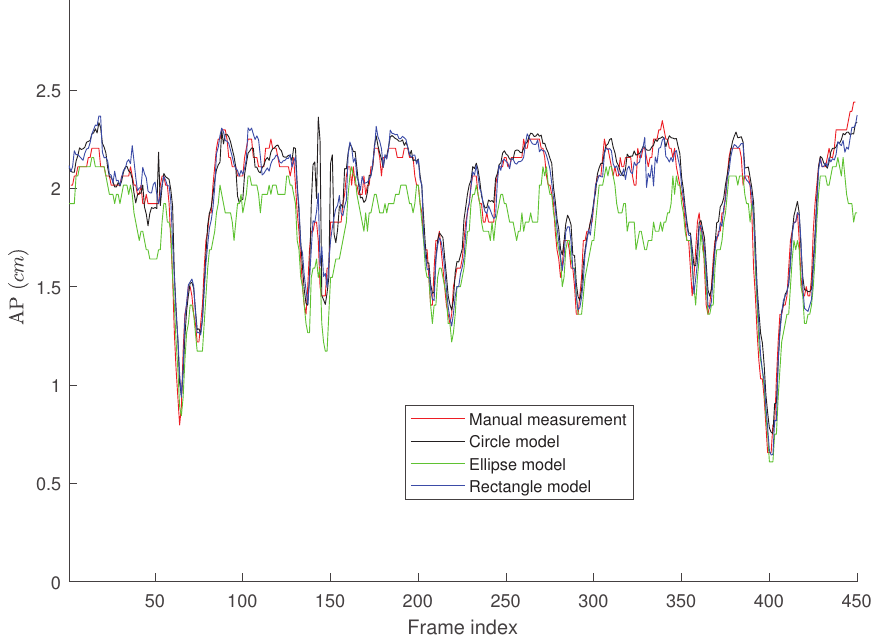
Figure 6. AP-diameter for the first video depicted in Figure 5, as measured by the manual measurement (red line), active circle algorithm (black line), active ellipse algorithm (green line) and active rectangle algorithm (blue